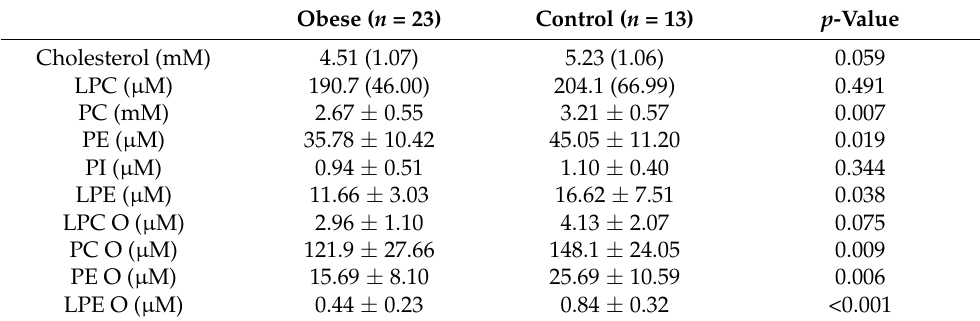
Table 6. Plasma cholesterol and phospholipids.